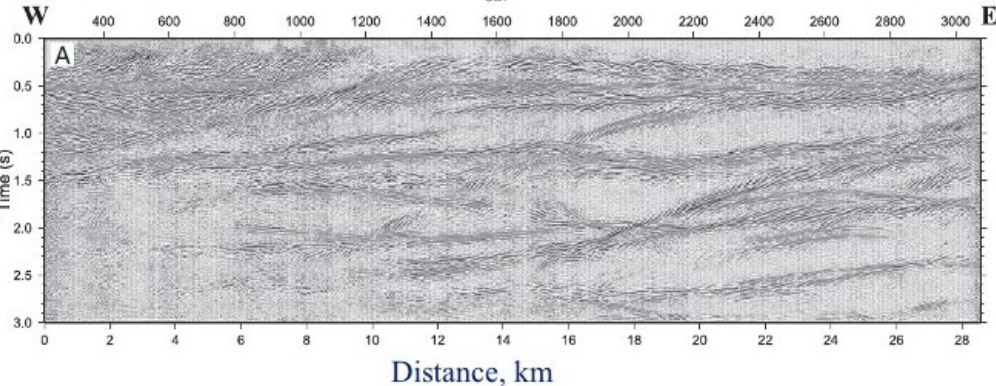
Figure 16. High amplitude, subhorizontal, and west dipping layered reflections from deep seismic surveys in west-central Sweden. Drilling and outcrop correlations identify these as thrust structures rather than intrusion [101].